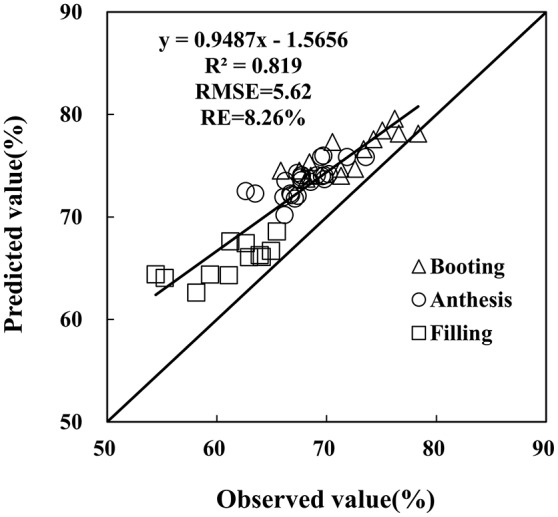
Comparison of predicted and observed wheat PWC based on the PRI in winter wheat. Data points from Experiment 4 (n = 52).